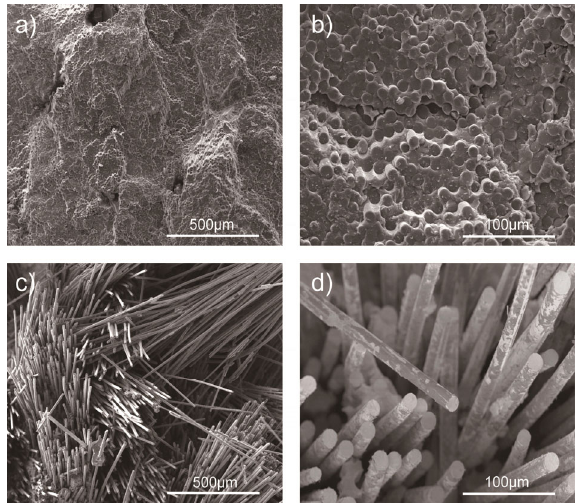
Fig. 5 Fracture morphologies of the KD-S SiC f /SiC composites (a, b) without and (c, d) with BN interface layer.